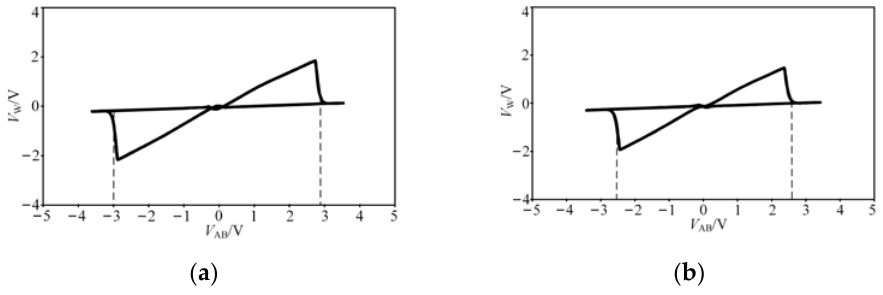
Figure 13. Simulation curves: ( a ) V ctr = 6 V, ( b ) V ctr = 2 V.